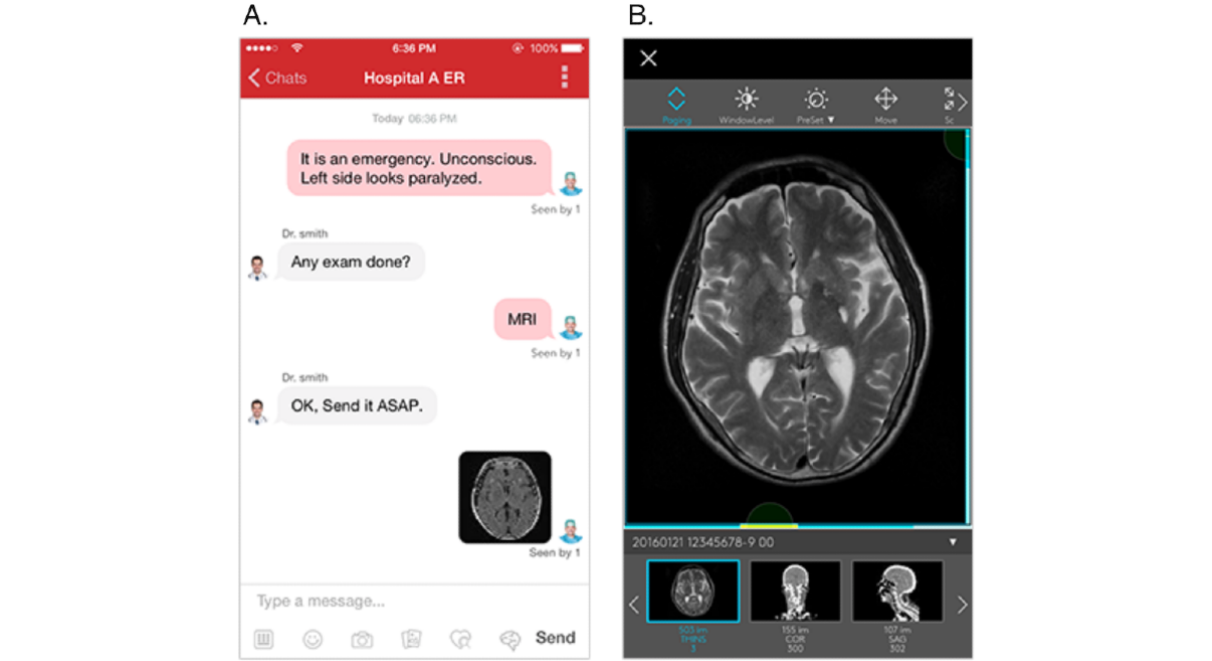
Figure 1. A. The Join smartphone app utilizes the easy-to-use interface of the social networking communication environment. B. Communication with picture archiving and communication system and other intrahospital systems enable text and medical images hosted on a cloud server to be shared in a group chat. The Join smartphone app displays diagnostic medical images, such as MRI and CT, and enables app users to edit, comment on, and draw a shape. CT: computed tomography. MRI: magnetic resonance